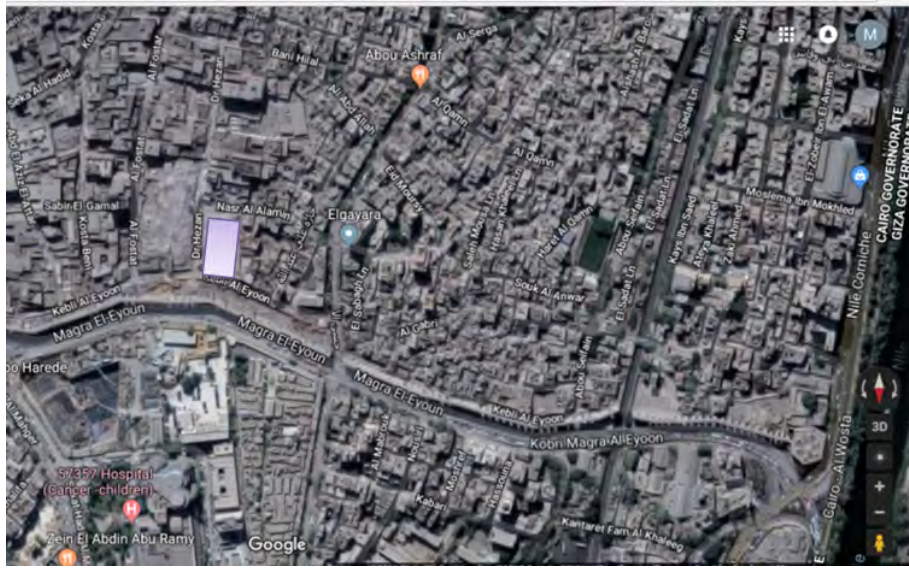
Figure 1. A satellite image for the whole zone (Google earth)